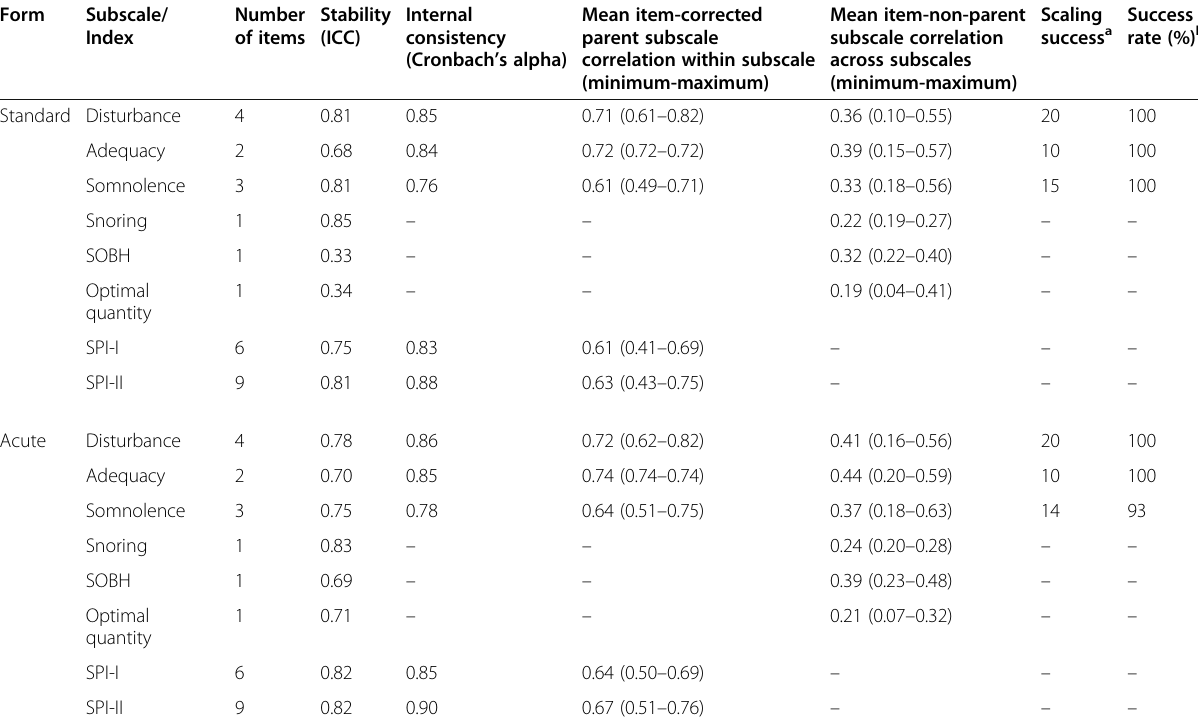
Table 4 Summary of internal consistency, stability, and construct validity for MOS Sleep-R standard and acute form subscales and global index